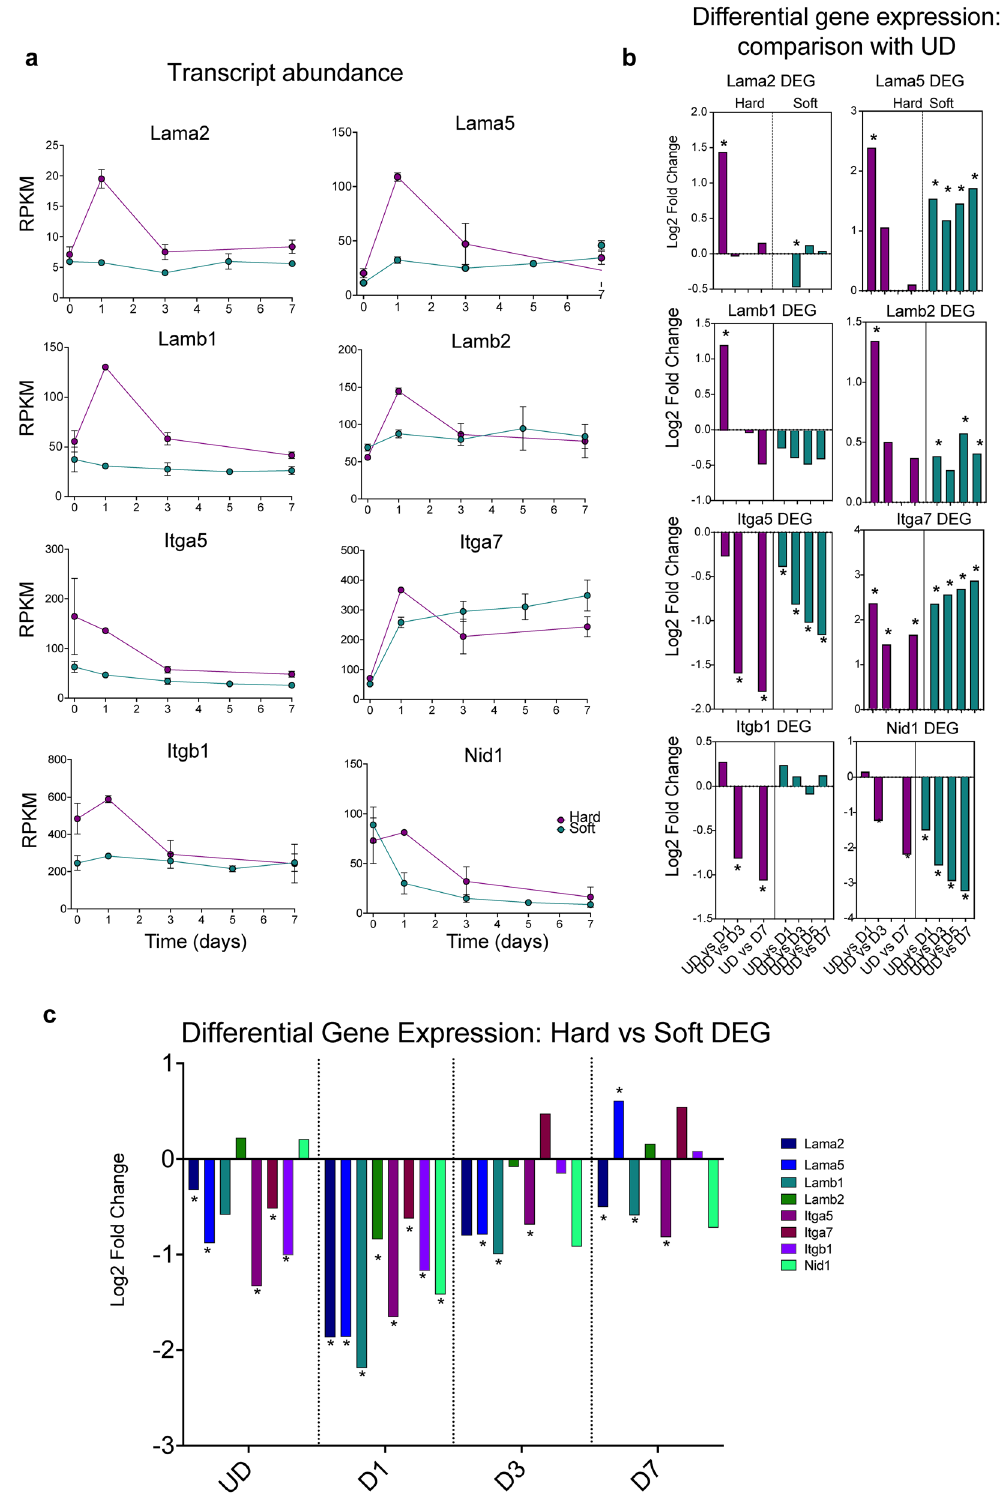
Figure 8. Expression of laminin, integrin and Nid1 (nidogen) genes on hard or soft surfaces in C1F cells. ( a ) RPKM plots for hard (magenta) and soft (green) surfaces for each of the genes of interest, over time. Day 0 (D0) represents undifferentiated cells (UD). Days 1–7 represent the time course of differentiation. Error bars show the standard deviation (S.D.). ( b ) DEG that compares expression for each gene over time, comparing UD with D1 etc. for cells cultured on hard and on soft surfaces. *Indicates significant change in log 2 fold expression (p adj value < 0.05). ( c ) DEG comparing expression of each gene for cells cultured on hard versus soft surfaces, at each time point. *Indicates significant change in log 2 fold expression (p adj value <